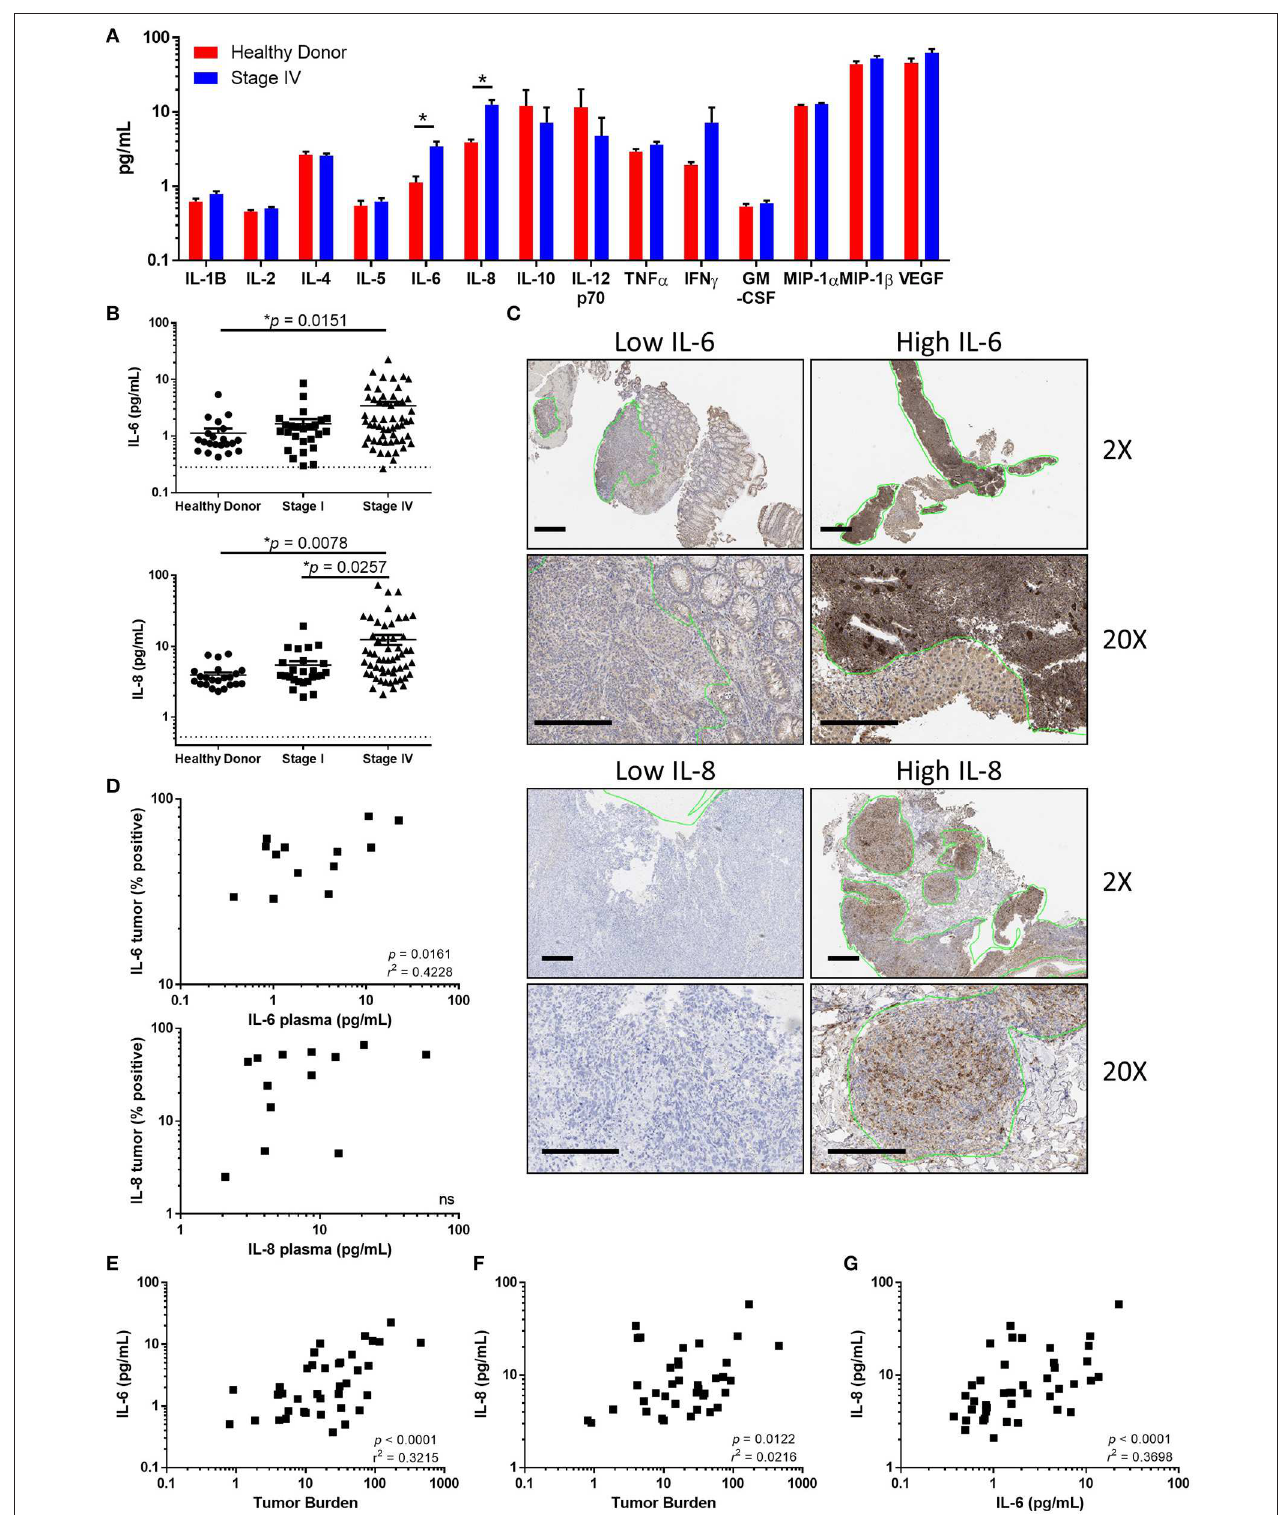
FIGURE 1 | Tumor associated IL-6 and IL-8 correlate with disease stage and tumor burden. (A) Analysis of circulating cytokines from healthy donors compared to stage IV melanoma patients. (Note: IL-13 was measured to be below the limit of detection and is not displayed). (B) Circulating IL-6 or IL-8 compared between healthy donors, stage I, and stage IV melanoma patients. Dotted line denotes limit of detection. (C) Paraffin-embedded tumor samples from stage IV patients were stained for